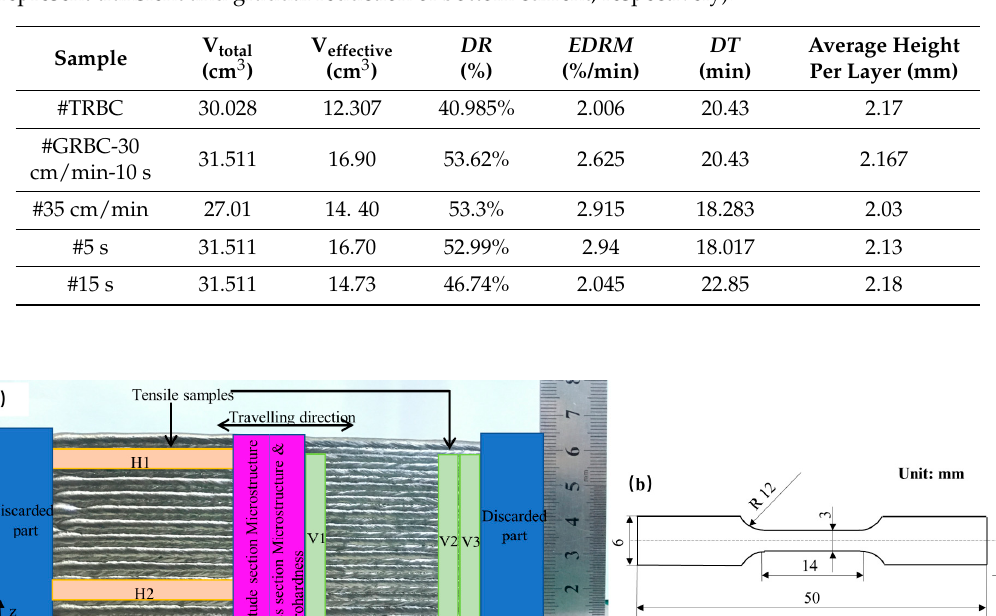
Table 3. V total , V effective , DR , EDRM , and DT values calculated for depositions (TRBC and GRBC represent transient and gradual reduction of bottom current, respectively).